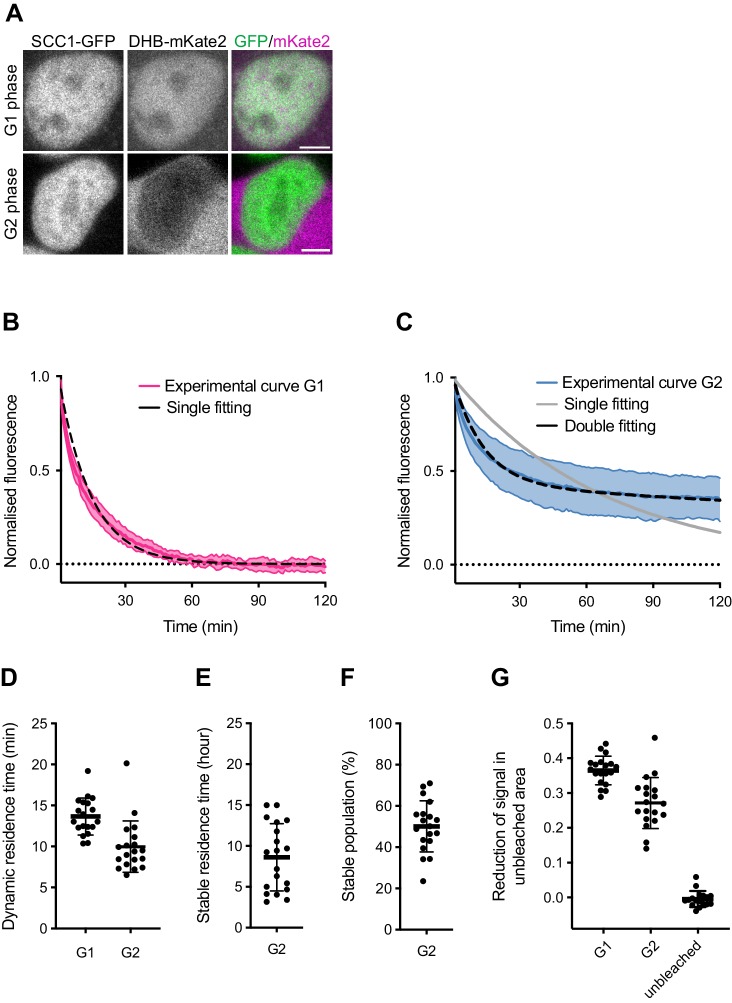
Dynamics and distribution of nuclear SCC1-mEGFP in G1 and G2 phase.(A) Images of SCC1-mEGFP cells in G1 and G2 phase, as distinguished by nuclear (G1) and cytoplasmic (G2) distribution of DHB-mKate2. Scale bar: 10 μm. (B) Curve fitting to experimental iFRAP curves obtained from G1 phase using a single exponential function (dashed black line). (C) Curve fitting to experimental iFRAP curves obtained from G2 phase by a single exponential function (dashed cyan line) and double exponential functions (dashed black line). (D) Residence times of dynamically bound SCC1-mEGFP in G1 and G2 were measured from individual curves by a single exponential function in (B) and by double exponential functions in (C), respectively, and plotted (mean ± S.D.). (E) Residence time of stably-bound SCC1-mEGFP measured from individual curves by double exponential functions in (C) and plotted (mean ± S.D.). Dots indicate individual cells. (F) Population of stably-bound SCC1-mEGFP expressed as a percentage of total chromatin-bound SCC1-mEGFP, measured from individual curves by double exponential functions in (C) and plotted (mean ± S.D.). Dots indicate individual cells. (G) Reduction of fluorescent signals in unbleached area after photobleaching was quantified and plotted (mean ± S.D.). ‘unbleached’ shows the reduction in nuclear fluorescent signal in cells not subjected to iFRAP within the same experiment. Dots indicate individual cells.